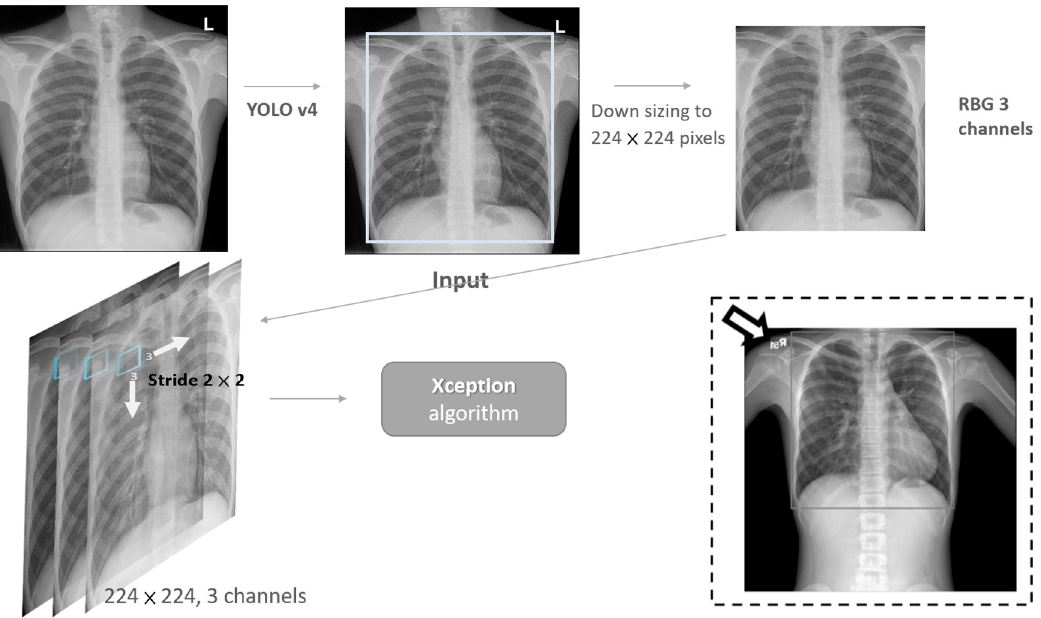
Figure 2. Image processing before input to Xception architecture. Miniature in dashed box shows how images were matted through YOLOv4 processing. The frame was just abutting the chest cage to exclude unnecessary features. Arrow: extra mark in clinical use.